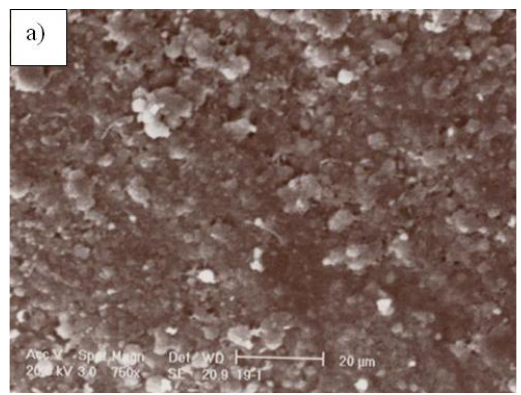
Fig. 9. SEM micrograph of zeolite NaA membrane cross section preparation of chemical source